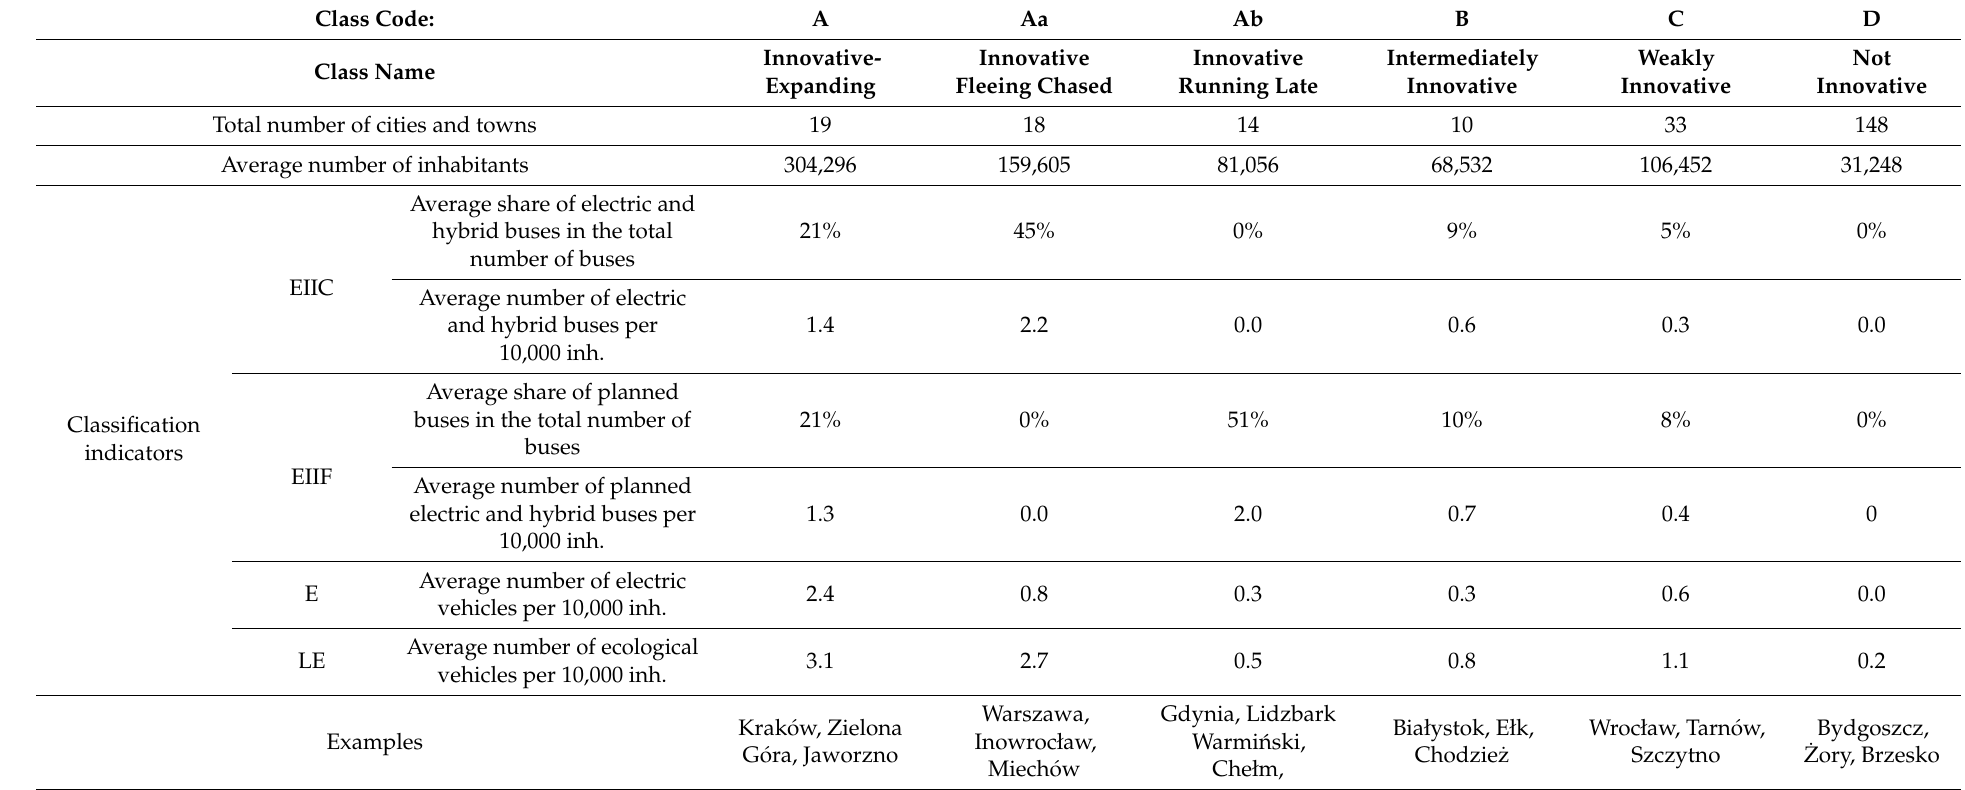
Table 7. Classification of cities in terms of 2nd generation